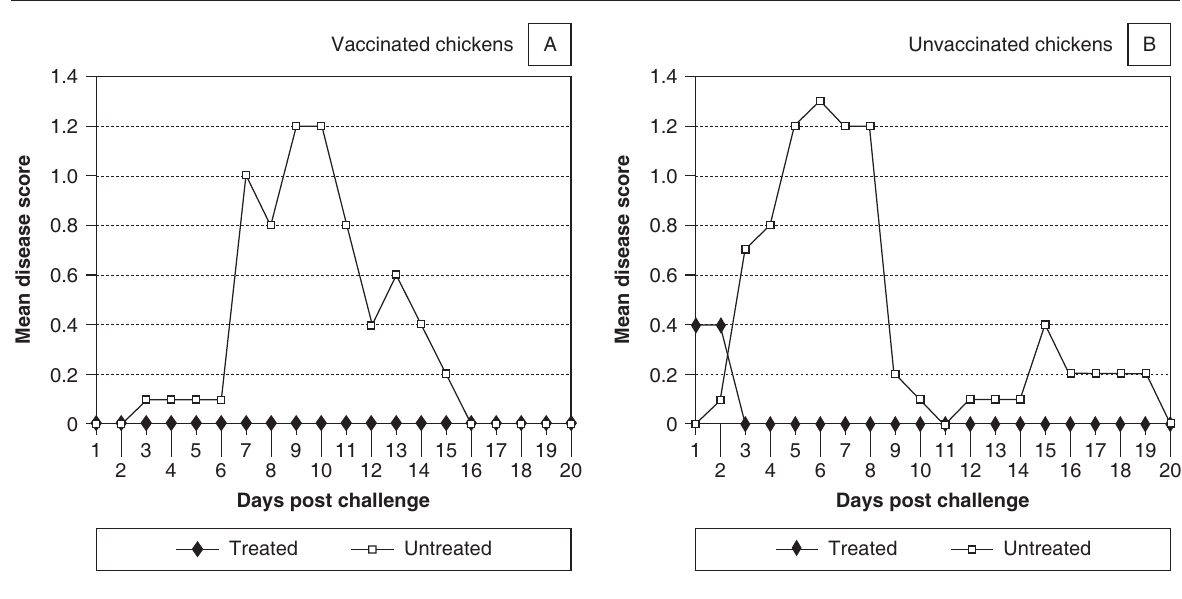
FIG. 5 Disease profiles of vaccinated (A) and unvaccinated (B) chickens challenged with an NAD-independent serovar C-3 iso- late of H. paragallinarum which were either treated with the continuous disinfection programme using Virukill (treated) or not treated in any other way